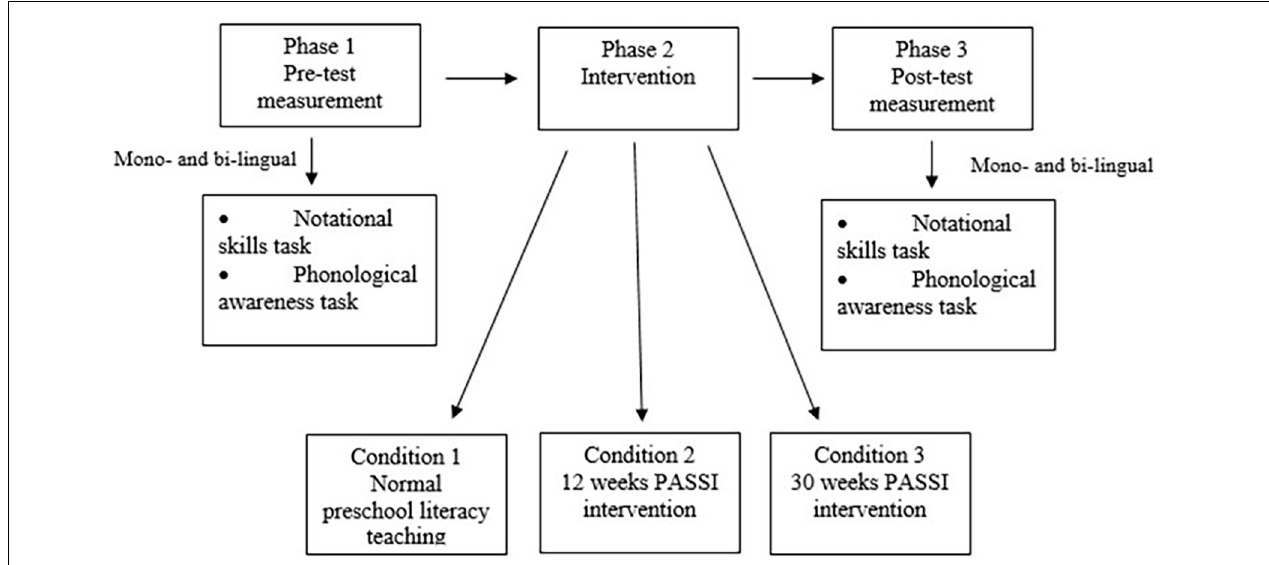
FIGURE 1 | Graphical representation of the research design.